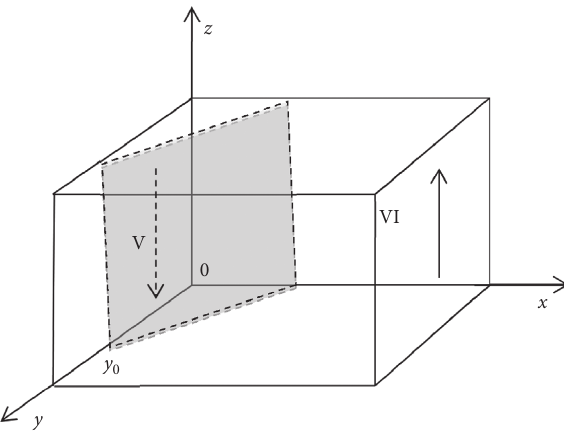
Figure 3: The enterprises’ dynamic evolutions. Table 3: Each subject’s strategies in different